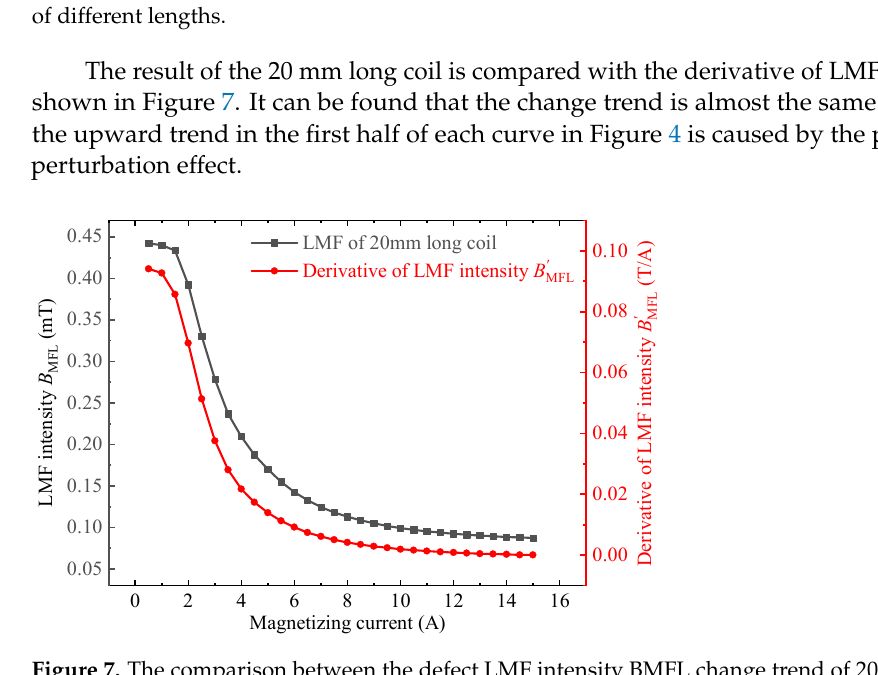
Figure 7. The comparison between the defect LMF intensity B MFL change trend of 20 mm long coil and the derivative of LMF intensity 𝐵 MFL ′ with the magnetizing current.